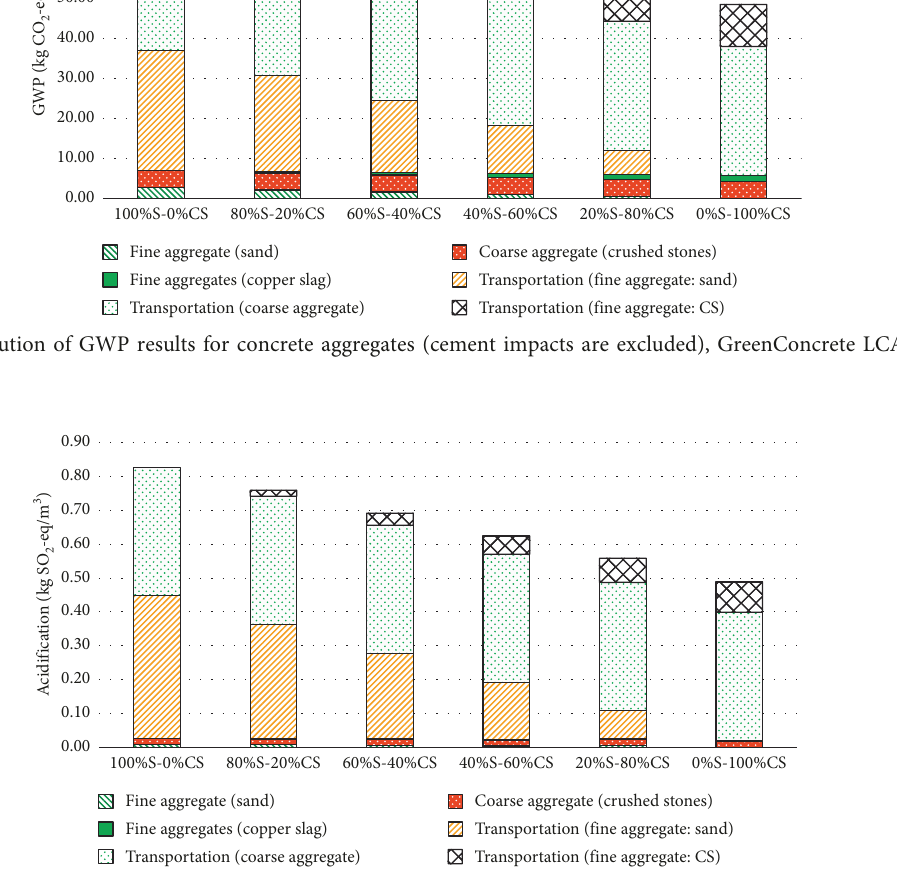
Figure 6: Distribution of acidification results for concrete aggregates (cement impacts are excluded), GreenConcrete LCA tool